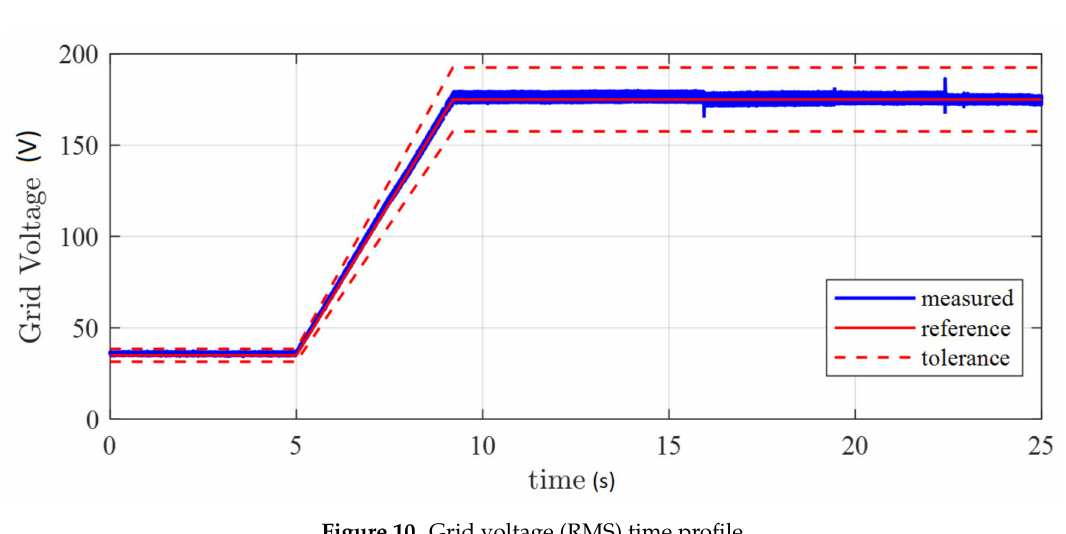
Figure 10. Grid voltage (RMS) time profile.